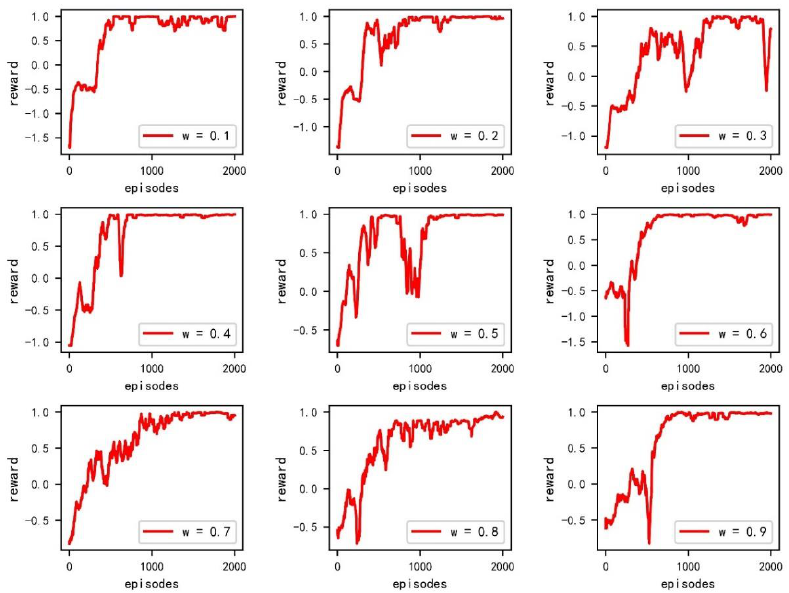
Figure 4. Normalization reward with different values of 𝑤 .